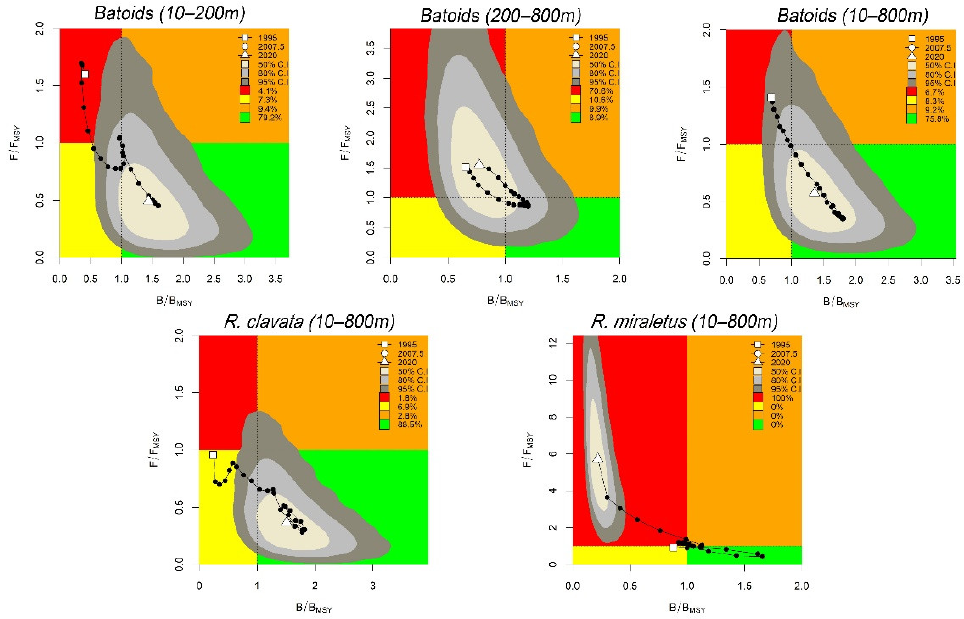
Figure 4. Dynamics of batoid stocks in GSA16 estimated by the AMSY model. F/F MSY versus B/B MSY . Quadrants are colour-coded: red: stocks that are both overfished (low relative biomass) and subject to overfishing (high exploitation rate) (B ≤ B MSY ; F ≥ F MSY ); orange: relative biomass is quite high but the exploitation rate is high (B ≥ B MSY ; F ≥ F MSY ); yellow: recovering stocks (B ≤ B MSY ; F ≤ F MSY ); green: stocks subject to a sustainable exploitation rate and with healthy stock biomass that can produce high yields close to MSY (B ≥ B MSY ; F ≤ F MSY ). Shaded areas indicate confidence intervals at 50% (light grey), 80% (grey) and 95% (dark grey) of the reference points during the last year.